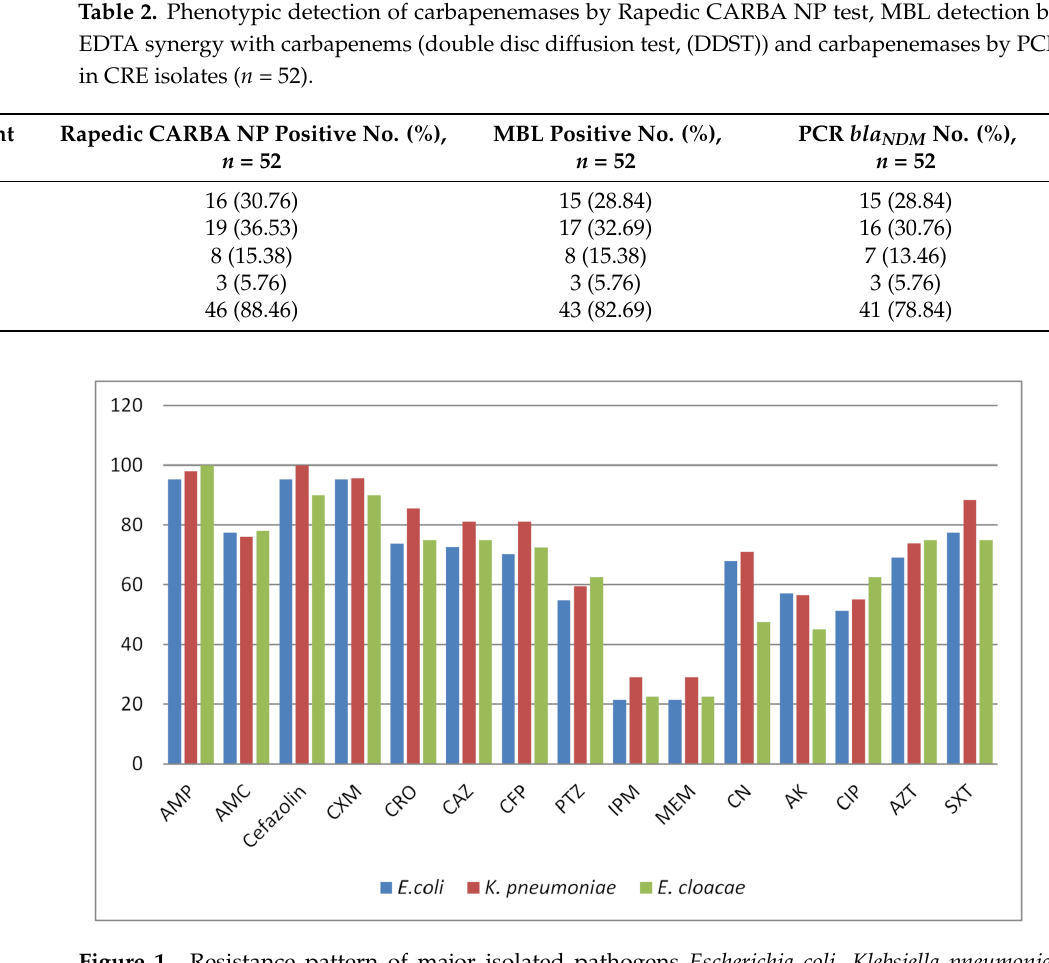
Figure 1. Resistance pattern of major isolated pathogens Escherichia coli , Klebsiella